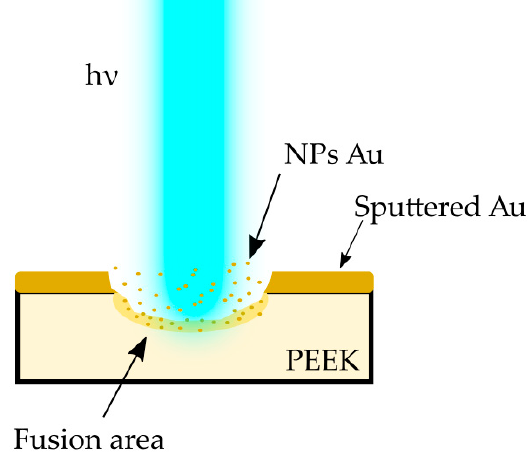
Figure 9. Scheme showing the interaction of a laser beam with matter.